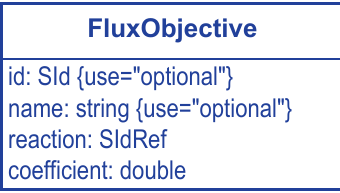
Figure 6: A UML representation of the Flux Balance Constraints package FluxObjective class. For a complete description see Figure 1 as well as Section 1.4 for conventions related to this figure.